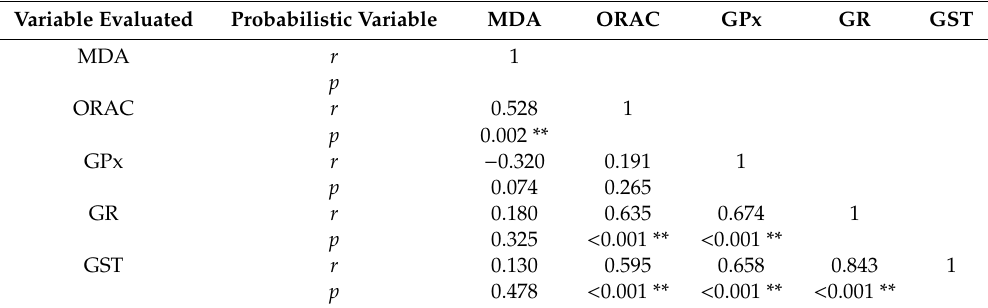
Table 3. Matrix of correlations between oxidative tissue damage, non-enzymatic antioxidant capacity and enzymatic antioxidant